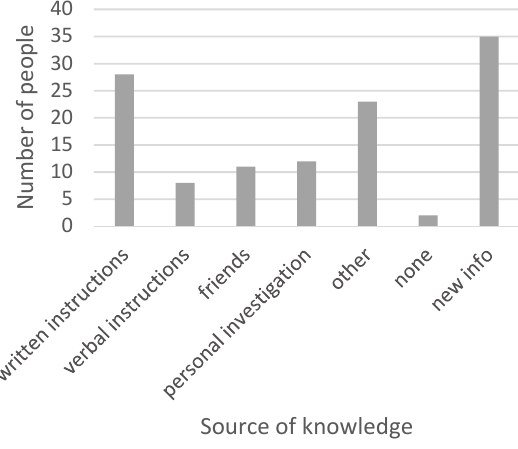
Figure A19. Perceived source of knowledge, second survey (93 individuals).